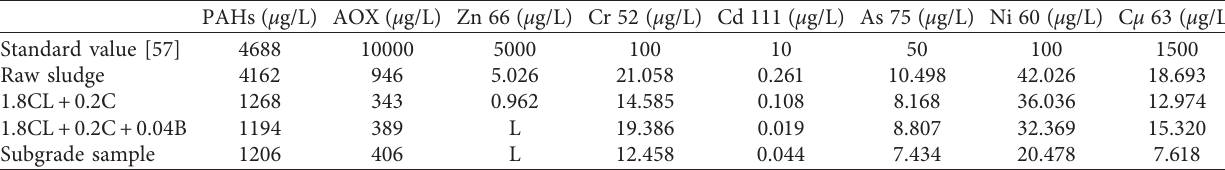
Table 6: Contrast table of the contamination indexes of samples.